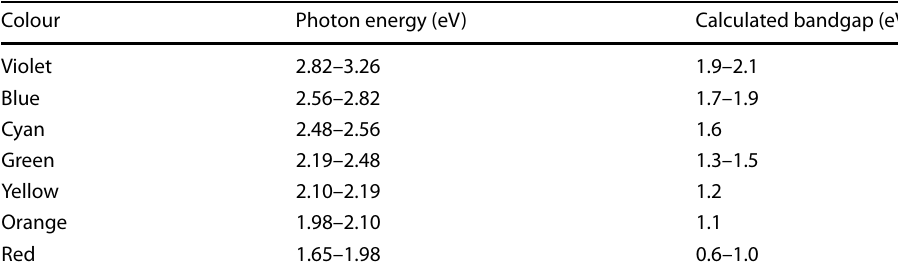
Table 2 Summary of PL colours, their related measured photon energies (corresponding to the real bandgap), and approximate values of the bandgap calculated using the standard DFT-GGA